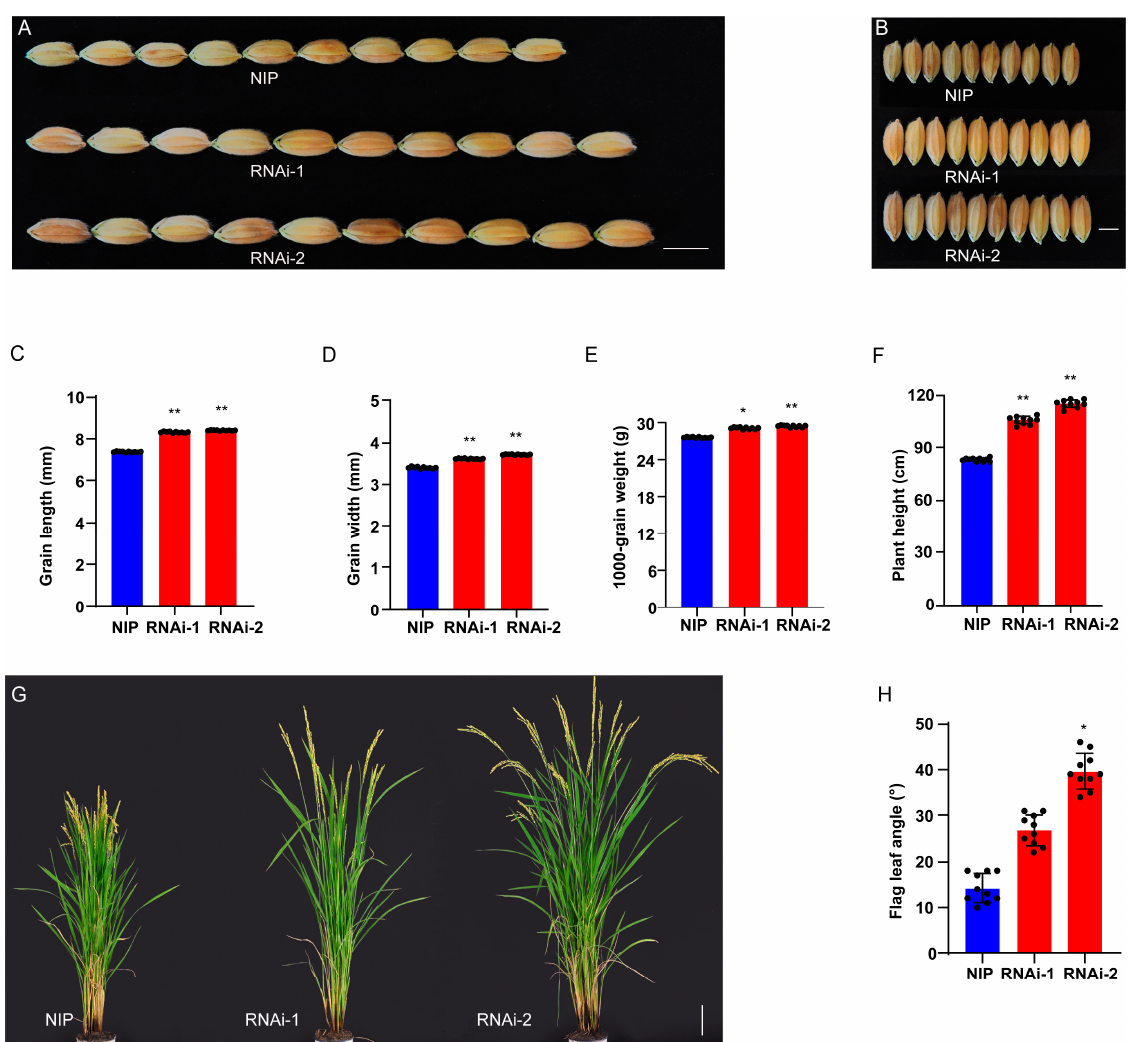
Figure 4. RNAi test at the mature stage . ( A ) Grain length of NIP and LG5- RNAi; bar = 6 mm. ( B ) Grain width of NIP and LG5- RNAi; bar = 3.5 mm. ( C – E ) Grain length, grain width, and thousand- grain weight of NIP and LG5- RNAi. ( F – H ) Plant height and flag leaf angle of NIP and LG5- RNAi; bar = 10 cm. Data are presented as means ± SD. * and ** indicate p < 0.05 and p < 0.01, respectively, according to Student’s t -test.